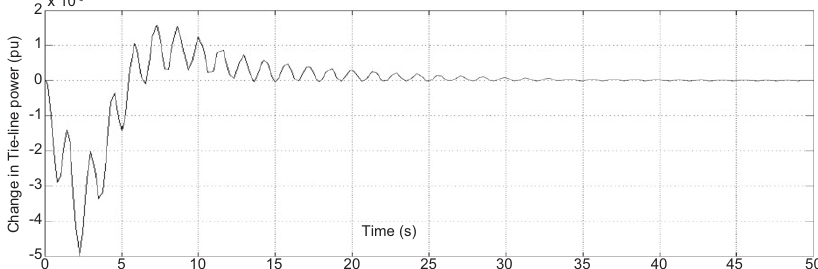
Figure 13. Change in Tie-Line Power (Hydro Plant): With Fuzzy